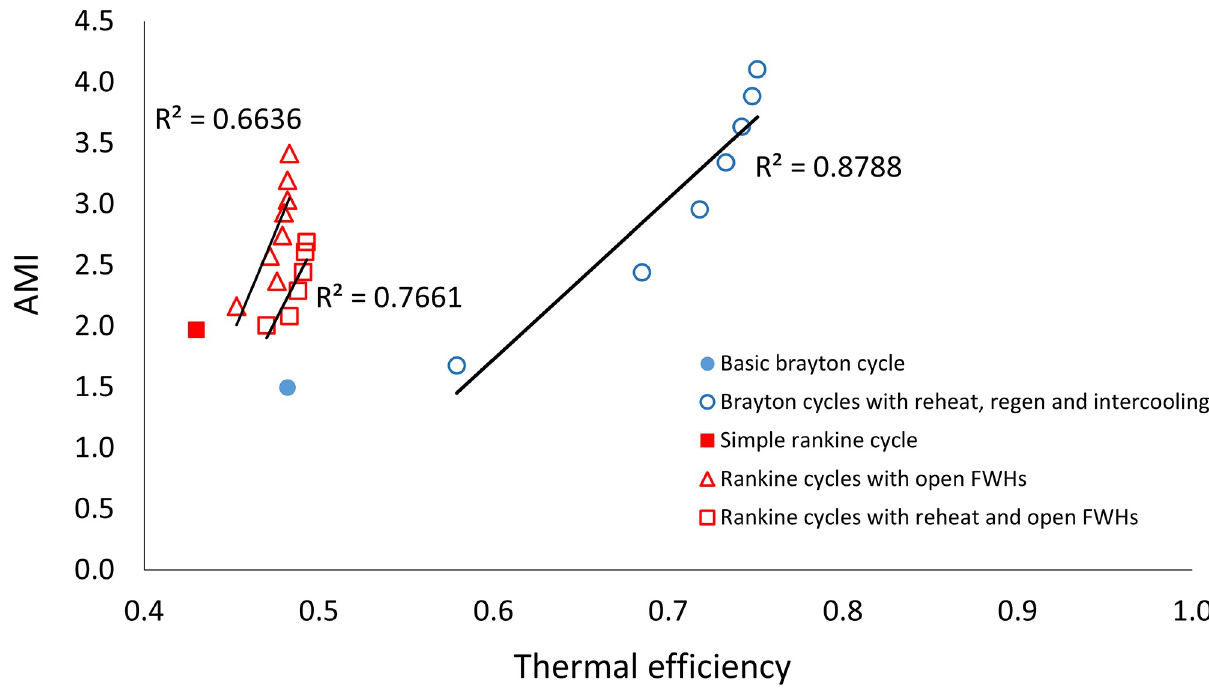
Fig 6. Thermal efficiency plotted against average mutual information ( AMI ) for the three sets of thermodynamic cycle improvements.